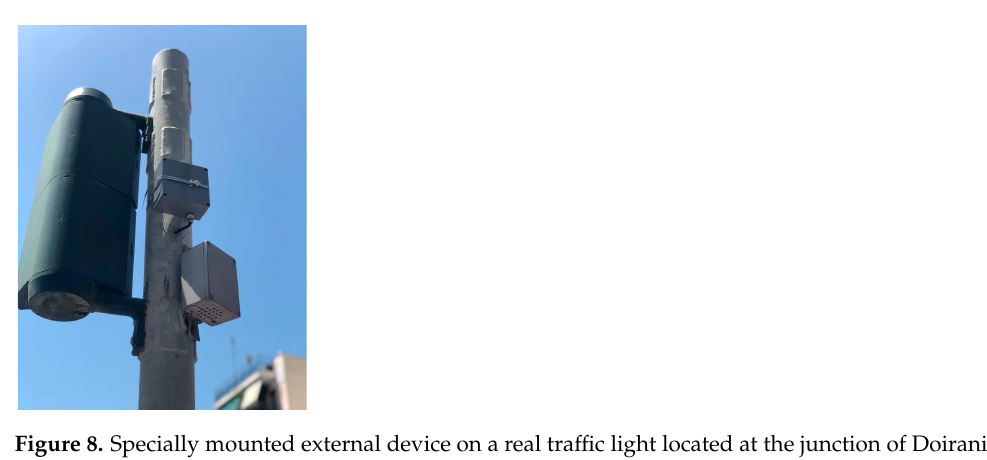
( b ) Figure 7. Application’s Training version—Snapshot from a simulated route ( a ) while it is being re- played. The instructor pauses the replay and selects to move the position of the user in an arbitrary location on the map in order to demonstrate the behavior of the app when a wrong turn event oc- curs. Upon selecting the new position, the old is grayed out ( b ). The text in both figures displays the message when the instructor paused the replay: “Upcoming right turn in 1 meter